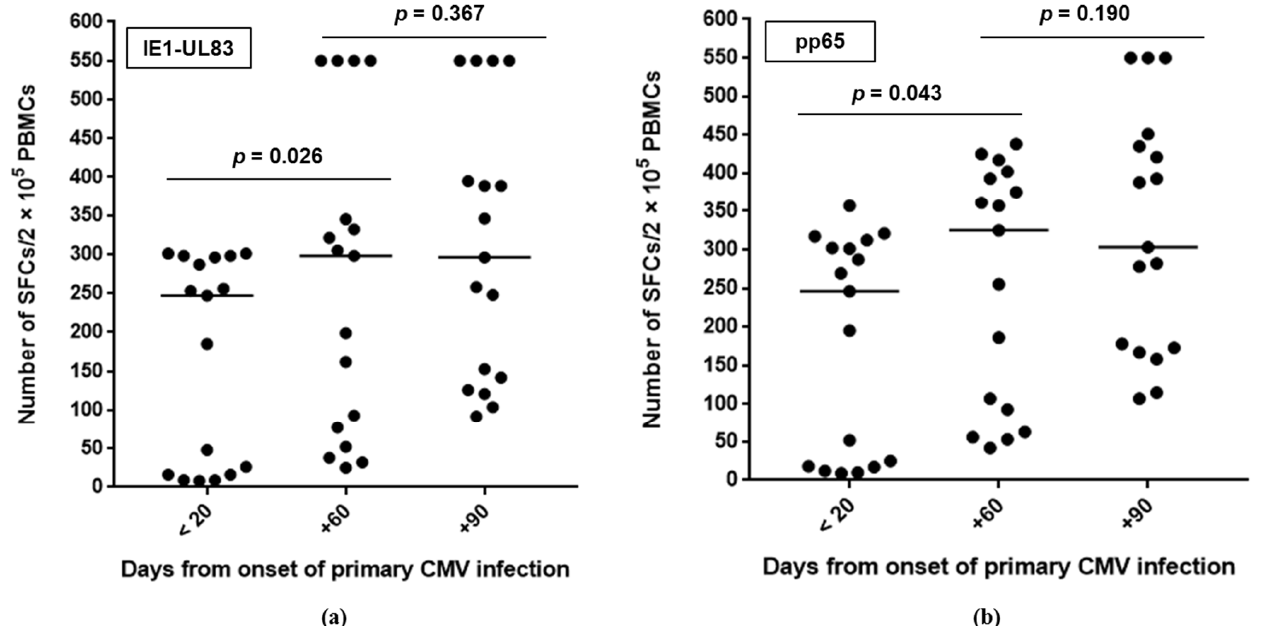
Figure 2. Number of cells reactive with CMV peptides during the three-month follow-up after primary CMV infection: ( a ) pp65-UL83 and ( b ) IE1. The line indicates the median value. SFCs, spot-forming cells; PBMCs, peripheral blood mononuclear